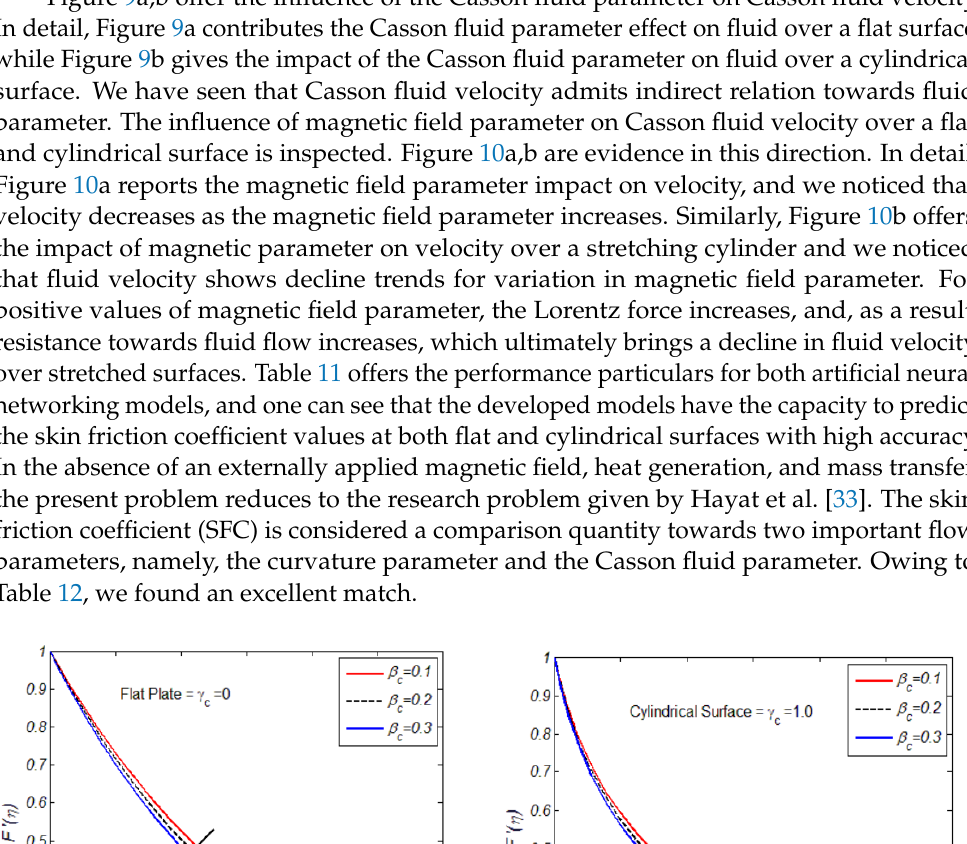
 Figure 9. ( a ) Impact of β c on velocity at flat surface; ( b ) Impact of β c on velocity at cylindrical surface. Figure 9. ( a ) Impact of c on velocity at fl at surface; ( b ) Impact of c surface.